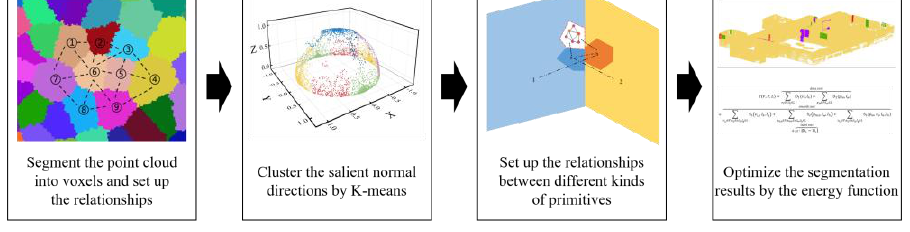
Figure 1. Overall workflow of the proposed method.